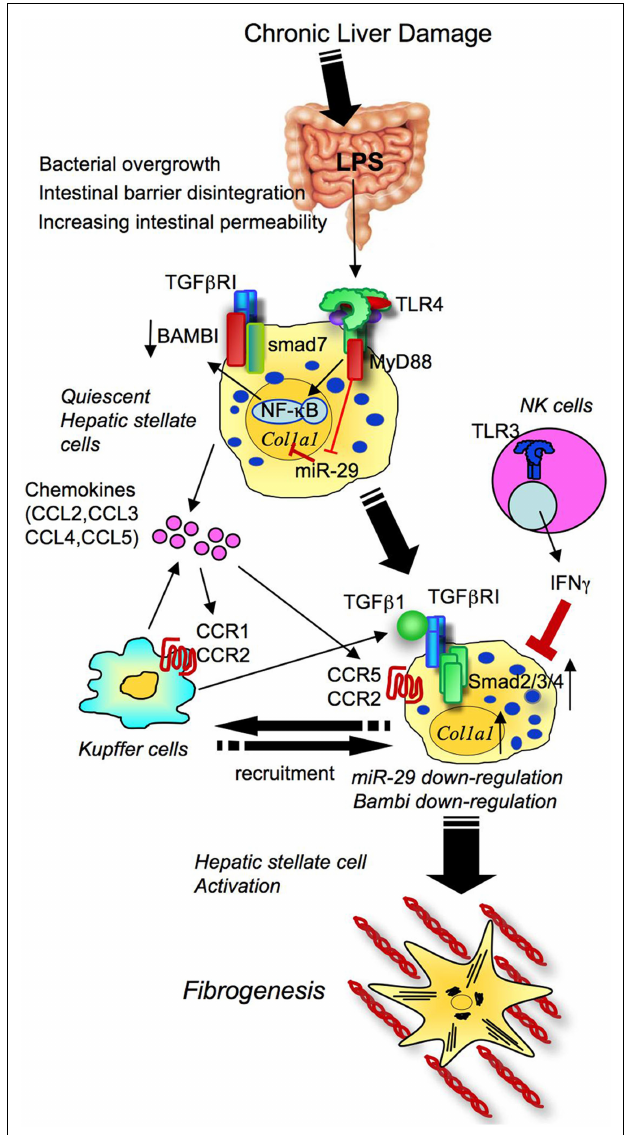
FIGURE 5 |Toll-like receptor signaling drives liver fibrosis through activation of hepatic stellate cells. In chronic liver damage, intestinal permeability is increased due to systemic inflammation, portal hypertension, intestinal dysbiosis, or tight junction disintegrity, leading to bacterial translocation.Translocated LPS stimulatesTLR4 on HSCs. Upon activation ofTLR4, HSCs produce chemokines to recruit Kupffer cells through CCR1 and CCR2, and Bambi is downregulated through MyD88 and NF- κ B.The fully activatedTGF- β signaling eventually induces HSC activation and liver fibrosis.TLR4 also inhibits miR-29 to enhance collagen production. CCR5 is important for HSC recruitment. Generally, the NK cells-TLR3-IFN γ axis suppresses HSC